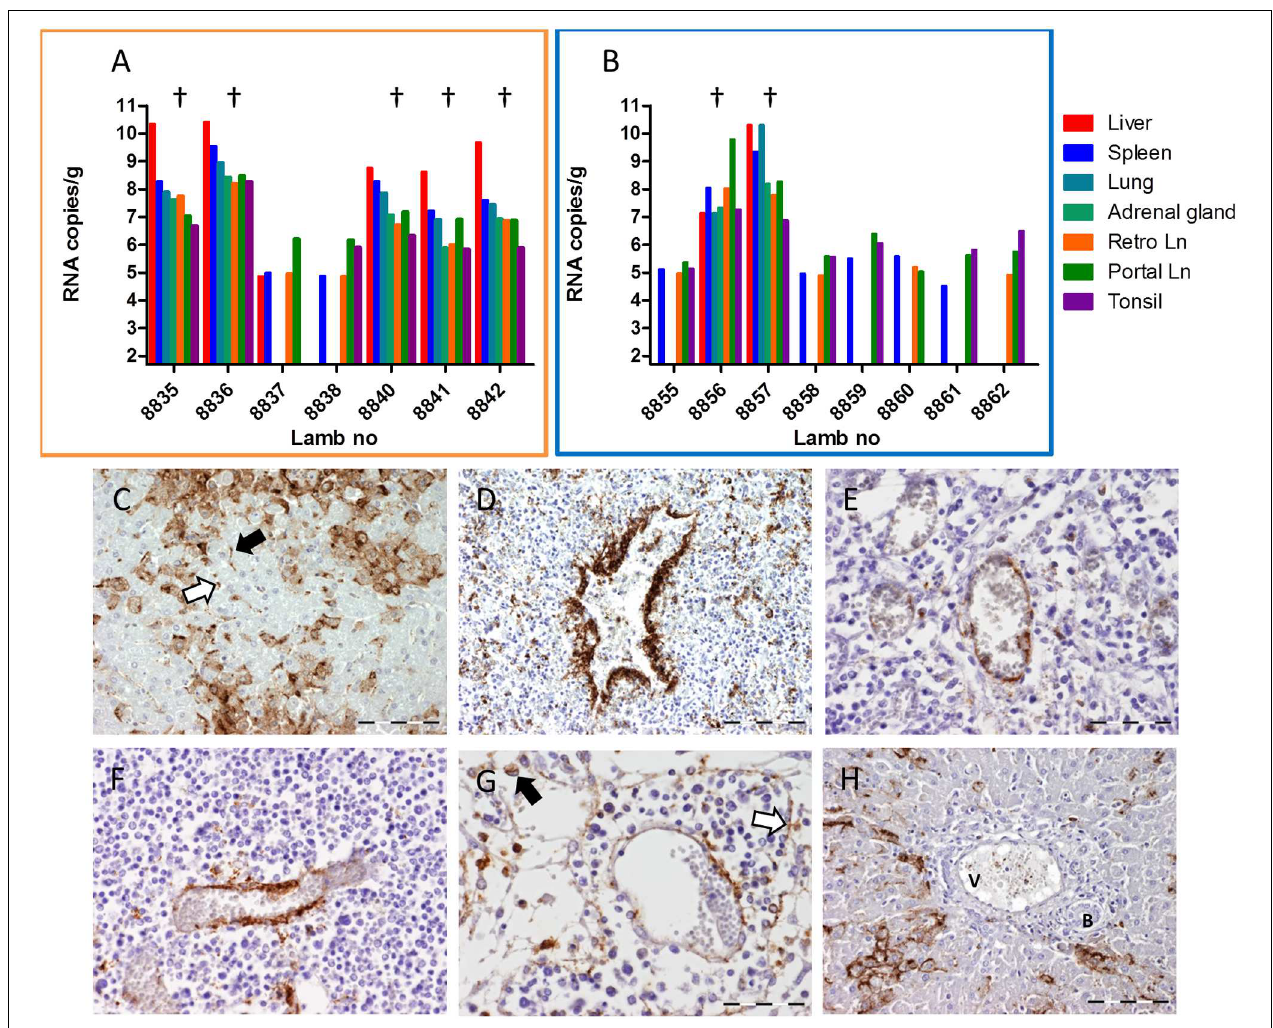
FIGURE 3 | Detection of viral RNA and viral antigen in organ samples collected from animals of Experiment B. Detection of viral RNA by qRT-PCR in organ samples collected from contact-exposed and subsequently challenged lambs (orange frame, A ) and of infected control lambs (blue frame, B ). Lambs that succumbed to the infection are marked ( † ). (C–H) Immunohistochemical staining of organ samples collected from lamb 8836. (C) Detail of liver acinus with strong immunostaining of hepatocytes. Also note the accumulation of RVFV antigen in Kupffer cells (black arrow) and circulating macrophages (white arrow) within the liver sinusoids. (D–G) Positive staining for RVFV antigen in the endothelial cells of venules and veins in (D) spleen; (E) tonsil; (F) paracortex of the retropharyngeal lymph node; and (G) medulla of the portal lymph node. Also note the positive staining in the circulating macrophages (black arrow) and littoral cells (white arrow) in